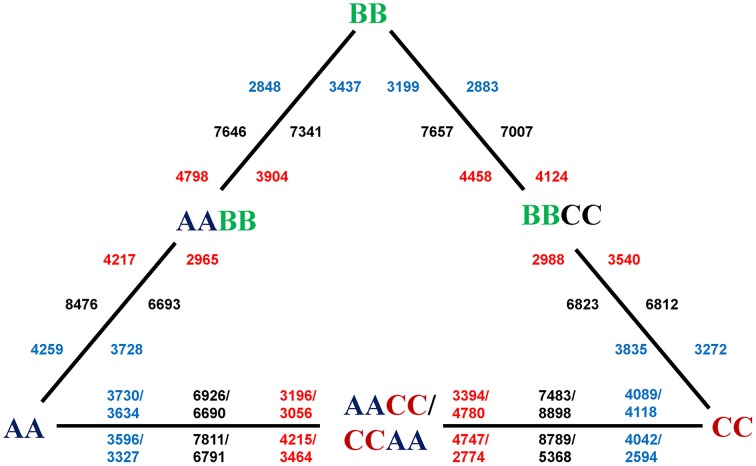
DEGs between synthetic allotetraploids and their diploid parents. The numbers in the inner circle of the triangle are DEGs in leaves, and those on the periphery are DEGs in silique walls. The total number (black) of DEGs between each allotetraploid and one of parent is in the middle, the number of up-regulation (red) is close to the allotetraploid, and the number of down-regulation (blue) is near to the parent. The lower number of DEGs for the silique sample of CCAA might be caused by the fewer raw reads for the sequencing problems.